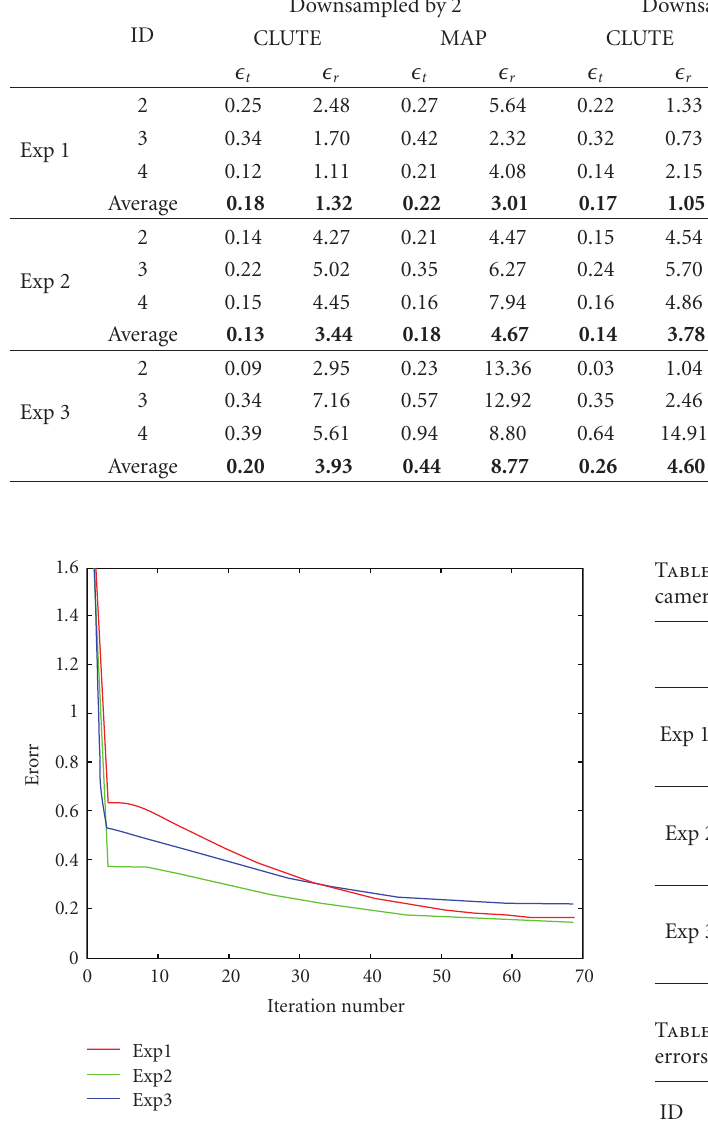
Figure 9: Evolution of the CLUTE translation error at each iteration in the three experiments.